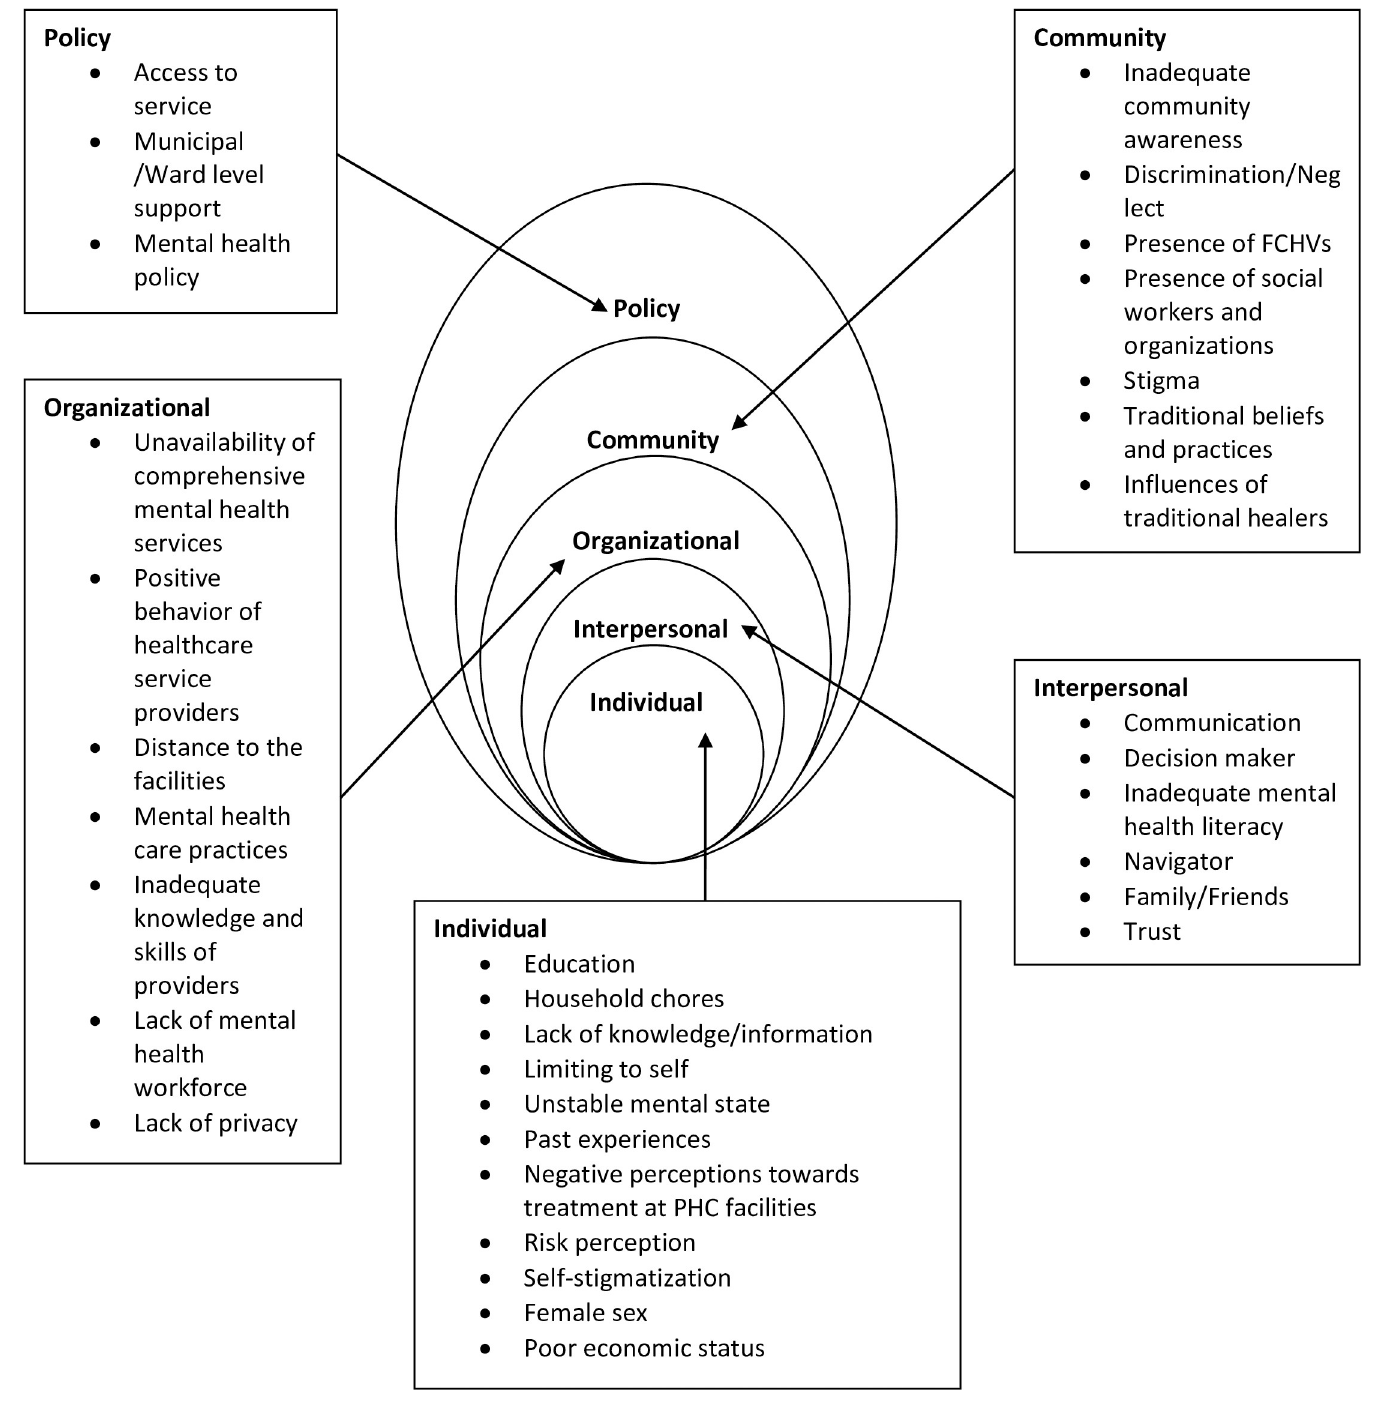
Fig 1. Thematic analysis (factors affecting mental health service